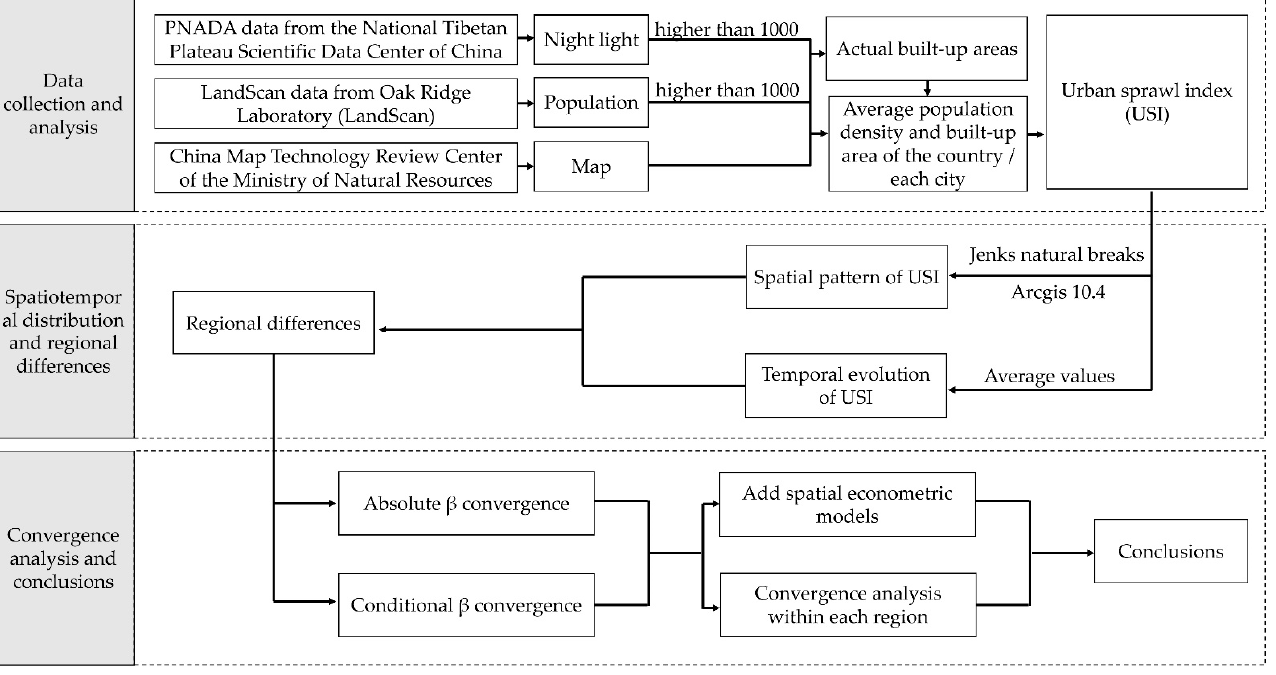
Figure 2. Workflow schema.